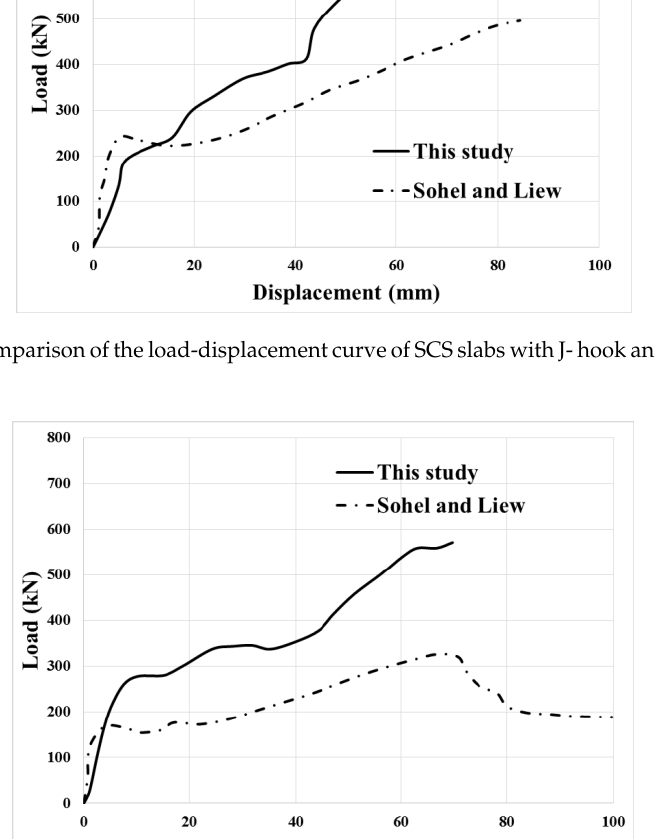
Figure 18. The comparison of the load-displacement curve of SCS slabs with stud bolt and CSC connectors with NWC core. Stiffness is an essential property and shows the resistance of specimens against the failure. This property is defined as an initial slop of the load- displacement curve of the specimens. So, the stiffness of specimens was measured. Moreover, to assess the structural performance of used connectors, the stiffness of specimens was also compared with that of previous investigation using J-hook and stud bolt connecters, as represented in Figures 15–18 [24,29]. The obtained results of the stiffness of specimens are demonstrated in Figure 19. According to this figure, the stiffness of SCS slabs with CSC connectors proposed in this study are higher than those produced with J- hook connectors by Sohel and Liew [24] and the stud bolt connectors by Ghalehnovi and